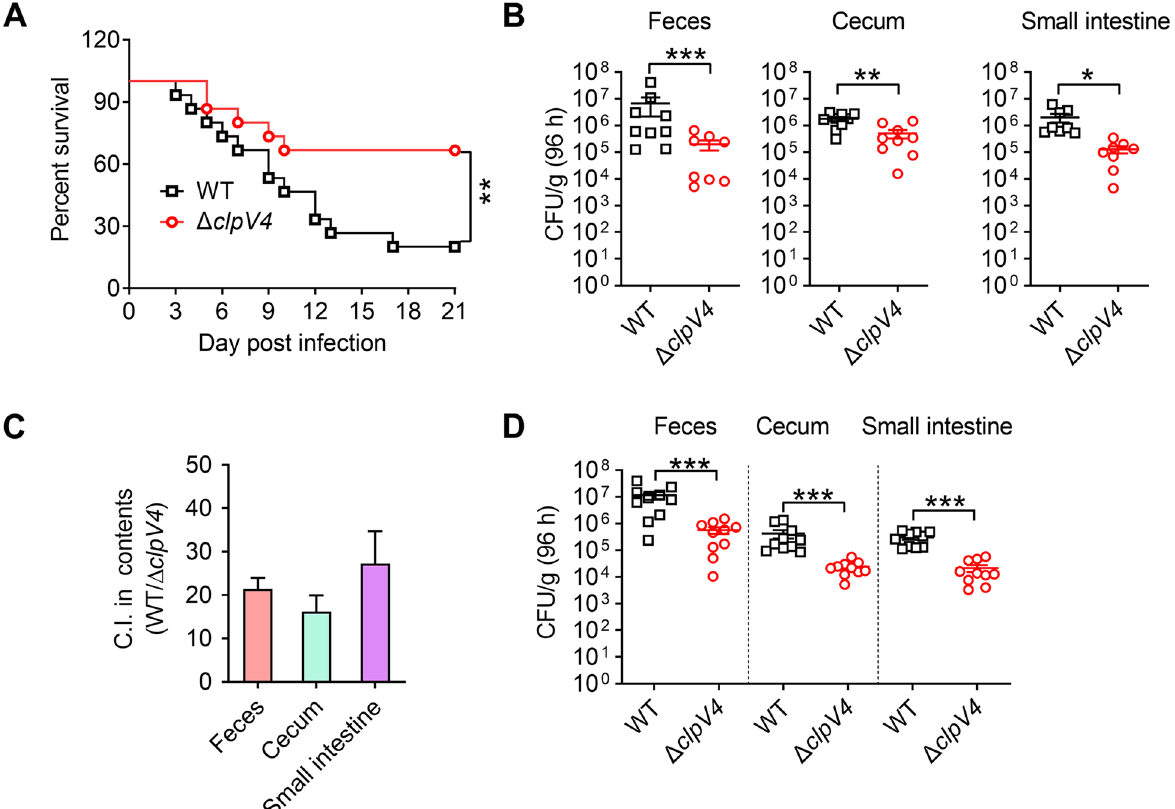
Fig. 5 T6SS4 enhances the virulence and colonization o f Y. pseudotuberculosis in infected mice. A‑B Y. pseudotuberculosis WT and Δ clpV4 (the main components of T6SS4) mutant strains grown in YLB were washed twice in sterilized PBS and used for orogastric infection of 6–7 weeks old female C57BL/6 mice using a ball-tipped feeding needle. For survival assays, 1 10 9 bacterial cells of each strain were applied to different groups × of mice ( n 15/strain), and the survival rate of the mice was determined ( A ). Enumeration of bacterial burdens in the feces, cecum, and small = intestine ( B ) of infected C57BL/6 mice at 4 days post-infection by CFU assays (